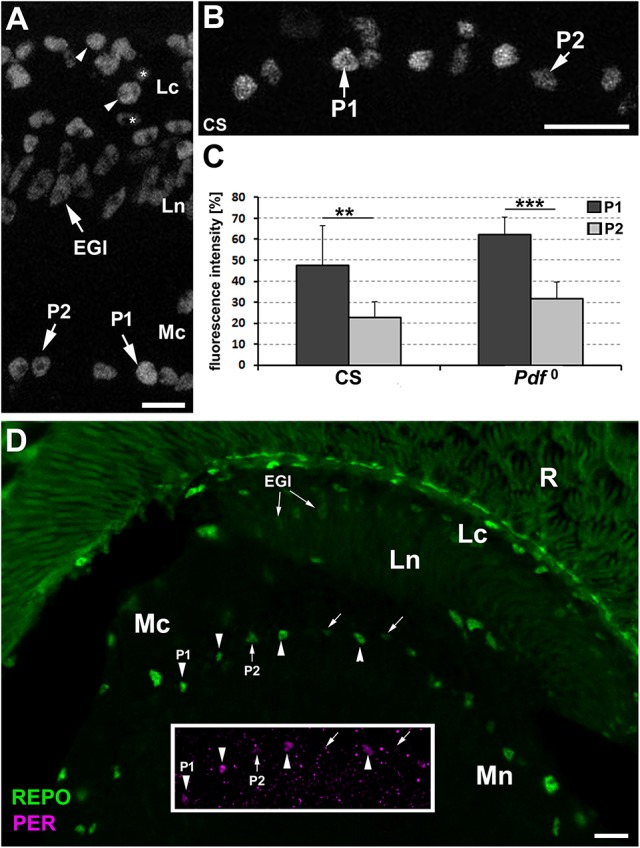
(A) The cross section of the lamina and the distal part of the medulla of CS immunolabeled with anti-REPO antibody. The staining reveals differences in the intensity of REPO-specific fluorescence in various types of glia. In the lamina cortex (Lc) some glial cells show higher level of fluorescence (arrowheads) than others (asterisks). Fluorescence of the epithelial glia (EGl) in the lamina neuropil (Ln) is more uniform and rather low. The dMnGl show both higher (P1 cell) and lower (P2 cell) levels of REPO-specific fluorescence. Mc-medulla cortex. Scale bar: 5 μm. (B) The P1 and P2 cells of the REPO-positive dMnGl are arranged in almost alternating order. Scale bar: 10 μm. (C) The average level of REPO-specific fluorescence (± SD) of the P1 and P2 dMnGl in CS and Pdf0 (**p < 0.01, ***p < 0.0001). (D) The frontal section of the lamina and the distal part of the medulla of CS labeled with anti-REPO and anti-PER (insert) antibodies. The nuclei of REPO-P1 cells (in the main picture, arrowheads) show strong PER-specific fluorescence (insert, arrowheads). The REPO- P2 cells (in the main picture, arrows) reveal weak or no PER-specific fluorescence (insert, arrows). R, retina; Lc, lamina cortex; Ln, lamina neuropil; EGl, the epithelial glia of the lamina; Mc, medulla cortex; Mn, medulla neuropil. Scale bar: 20 μm.